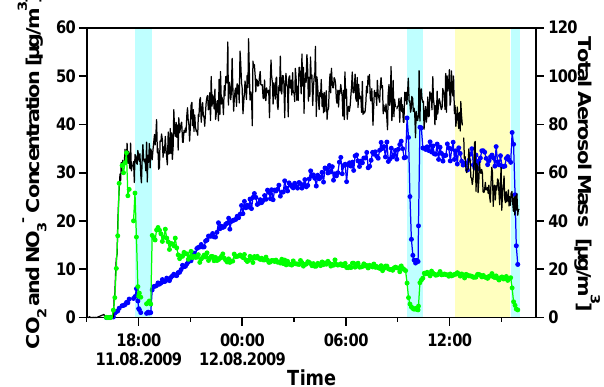
Fig. 11. Humidograms of calcium carbonate aerosols size selected Figure 11. Humidograms of calcium carbonate aerosols size selected at an electromobility at an electromobility diameter of 150nm measured in the dry Large diameter of 150 nm measured in the dry Large Aerosol Chamber (blue: after 1 h, black Aerosol Chamber (blue: after 1h, black rhomb: after 16h, turquoise rhomb: after 16 h, turquoise open triangles: after 20 h). The same in the humidified chamber open triangles: after 20h). The same in the humidified chamber at at 40%RH with 470 ppb NO X and 370 ppb O 3 added (red triangles: after 3 h, magenta 40%RH with 470ppbNO x and 370ppb O 3 added (red triangles: rhombs: after 18 h, orange triangles: after 20 h). In case of the measurements after 20 h the after 3h, magenta rhombs: after 18h, orange triangles: after 20h). aerosol was additionally dried before entering the HTDMA. For comparison the humidogram In case of the measurements after 20h the aerosol was addition- of calcium carbonate aerosol pre-processed with water from the laboratory study (green dots) ally dried before entering the HTDMA. For comparison the humi- is shown. Measurement errors: saturation ratio 0.014, GF 0.005 (shown exemplary for one dogram of calcium carbonate aerosol pre-conditioned with water data set). from the laboratory study (green dots) is shown. Measurement er- rors: saturation ratio 0.014, GF 0.005 (shown exemplary for one data set).